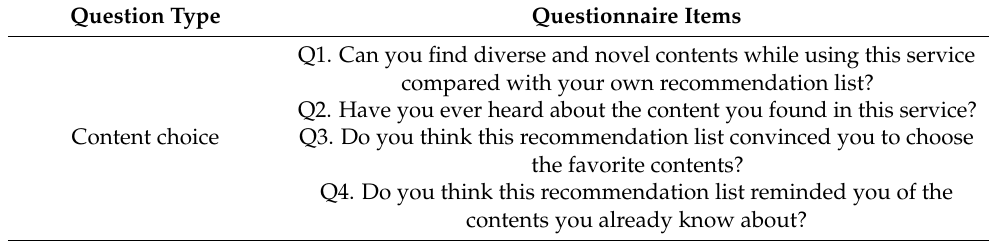
Table 1. Question lists of the follow-up interview.